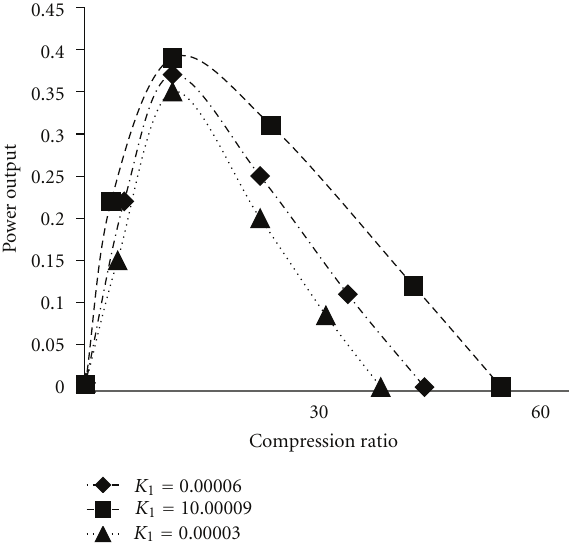
Figure 6: Compression of capability of algorithms to escape from restricted area.